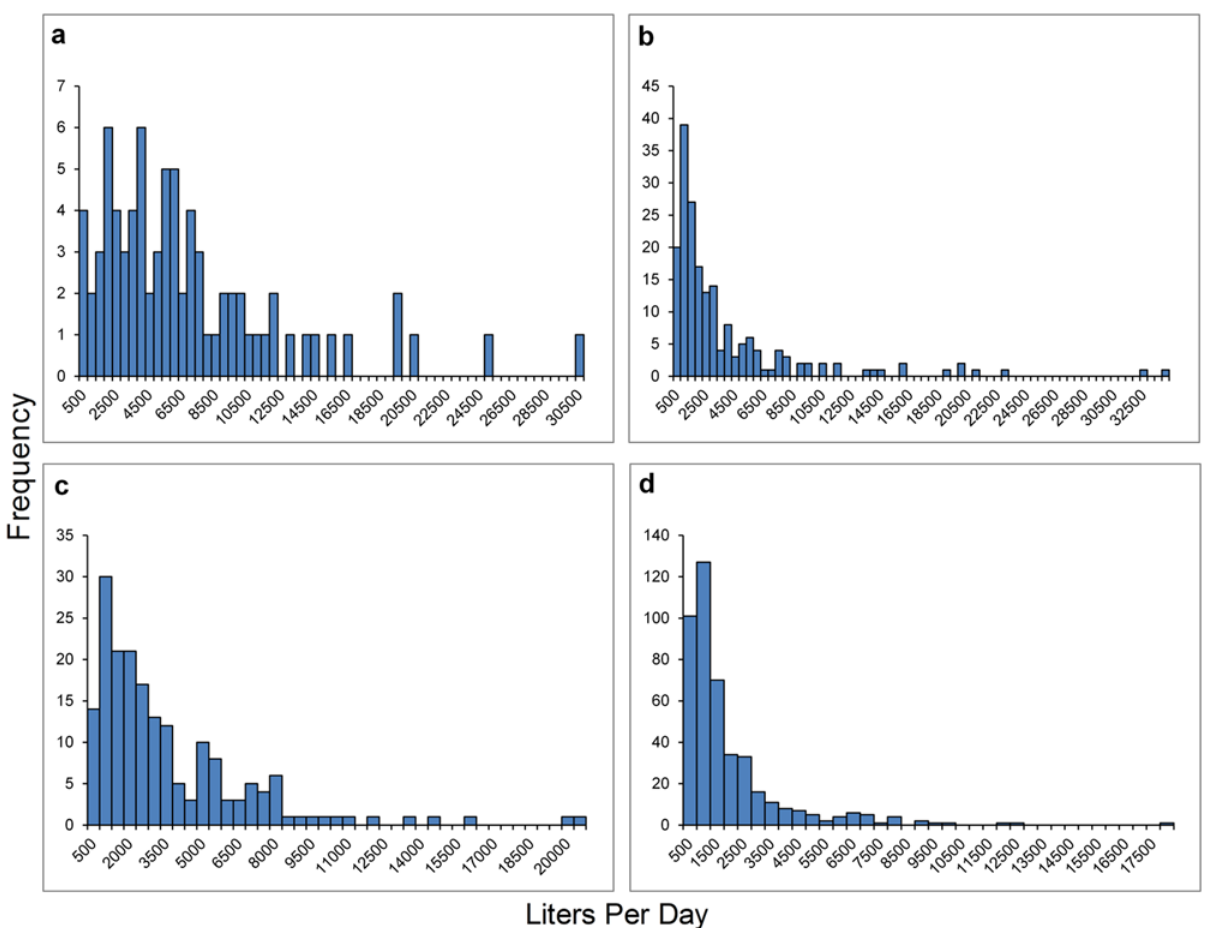
Fig 7. Frequency distribution of the water demand in liters per day (LPD) required per parcel for marijuana cultivation for each study watershed. (a) Upper Redwood Creek watershed, 79 parcels with marijuana cultivation, average water use 6622 LPD, (b) Salmon Creek watershed, 189 parcels with marijuana cultivation, average water use 3620 LPD, (c) Redwood Creek South watershed, 187 parcels with marijuana cultivation, average water use 3308 LPD, (d) Outlet Creek watershed, 441 parcels with marijuana cultivation, average 1642 LPD. See also S1